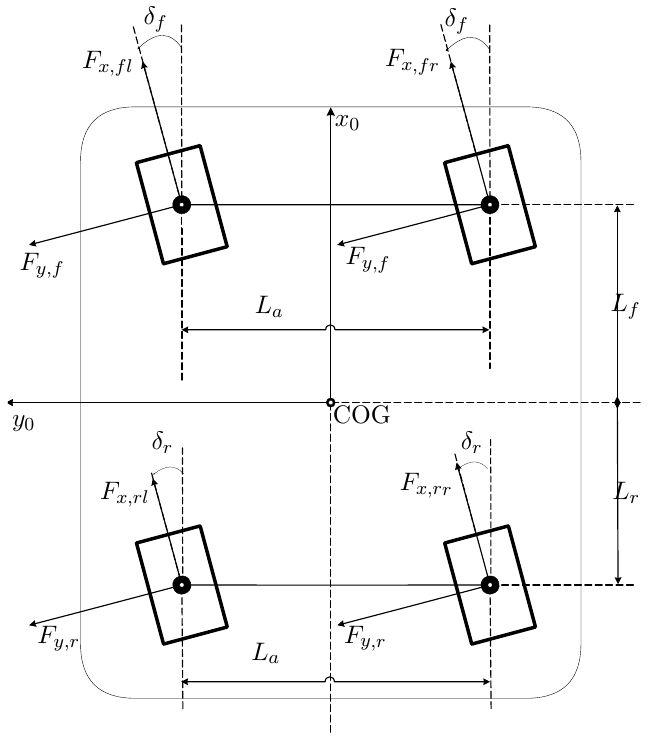
Figure 2. Steering system. COG: center of